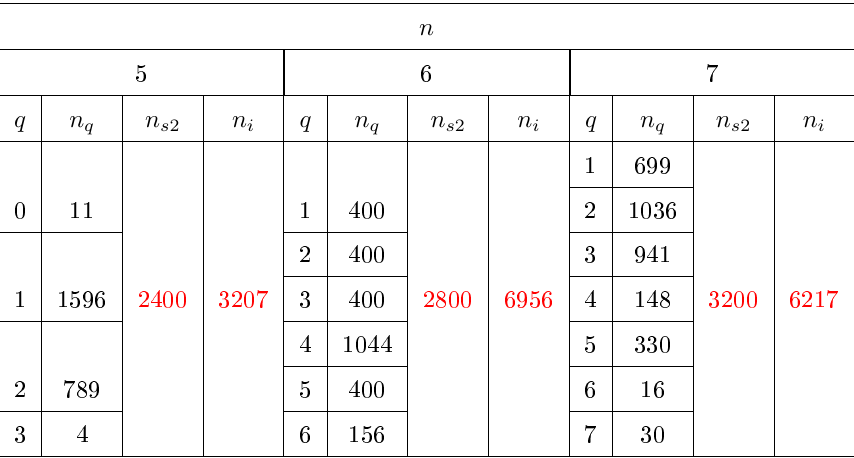
Table 7(b)-Parameters of